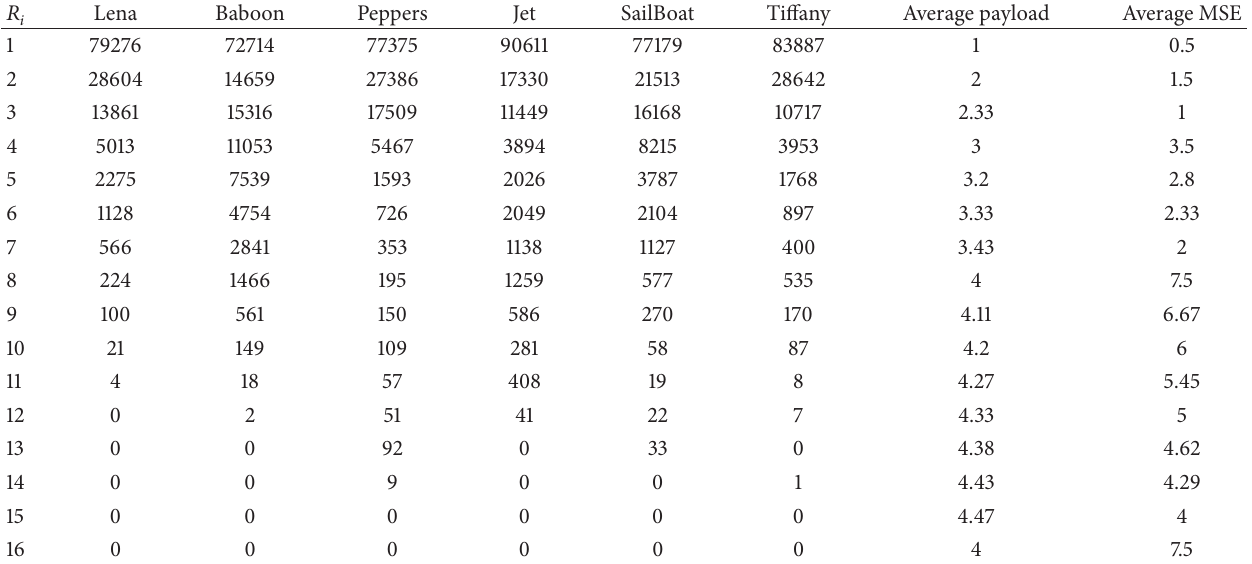
Table 2: Distributions of pixel-value difference, average payload, and average MSE for images using the proposed method. 𝑅 𝑖